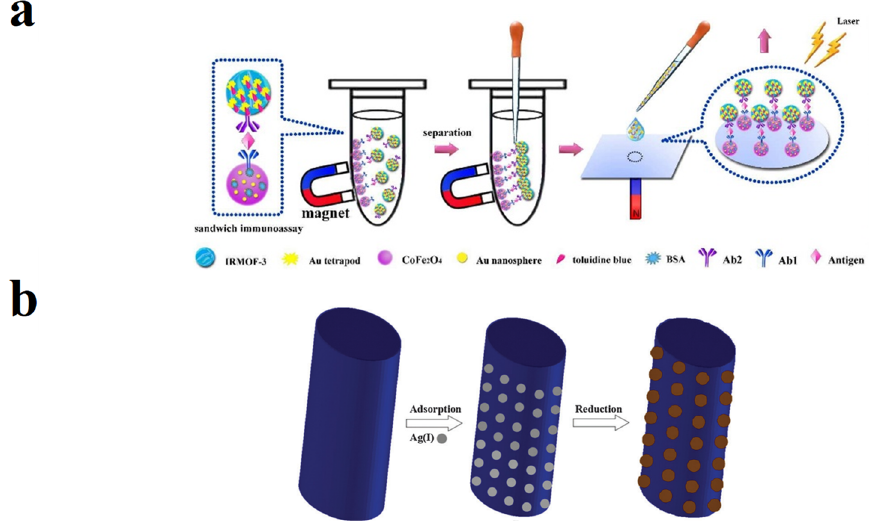
Figure 7. ( a ) Schematic diagram of SERS-based immunosensor for detecting NT-proBNP [98], ( b ) Schematic diagram of h-Ag NP formation on MOF [100].